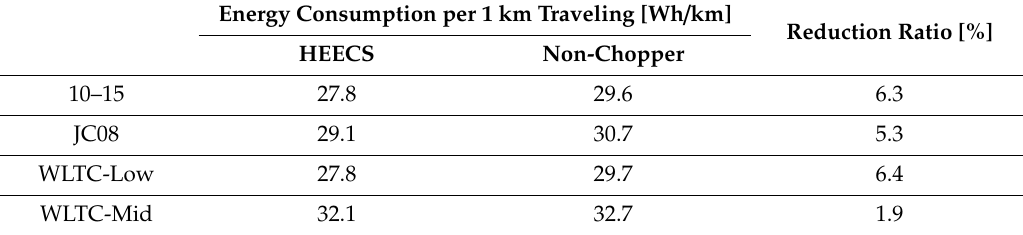
Table 5. Experimental results of energy consumption in test